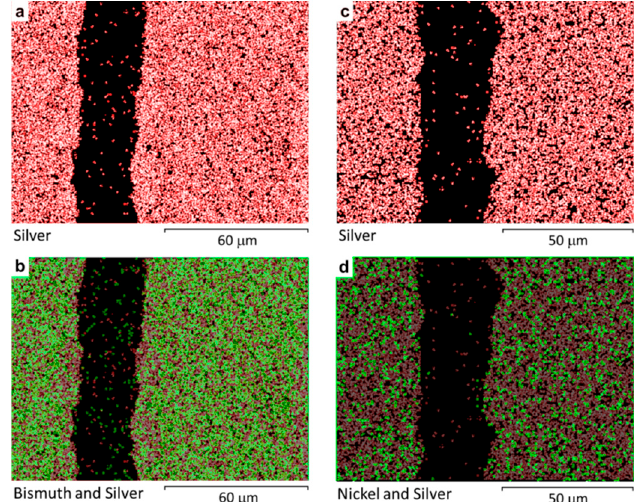
Figure 9. EDS elemental maps created from multi-layered ( a , b ) Bi/Ag and ( c , d ) Ni/Ag films where Ag is the base film displayed as red and Bi or Ni is used as an absorption layer displayed as green. In ( a ) and ( c ), only the base film is shown in red, while ( b ) and ( d ) display the base film with the absorption film overlaid in green.